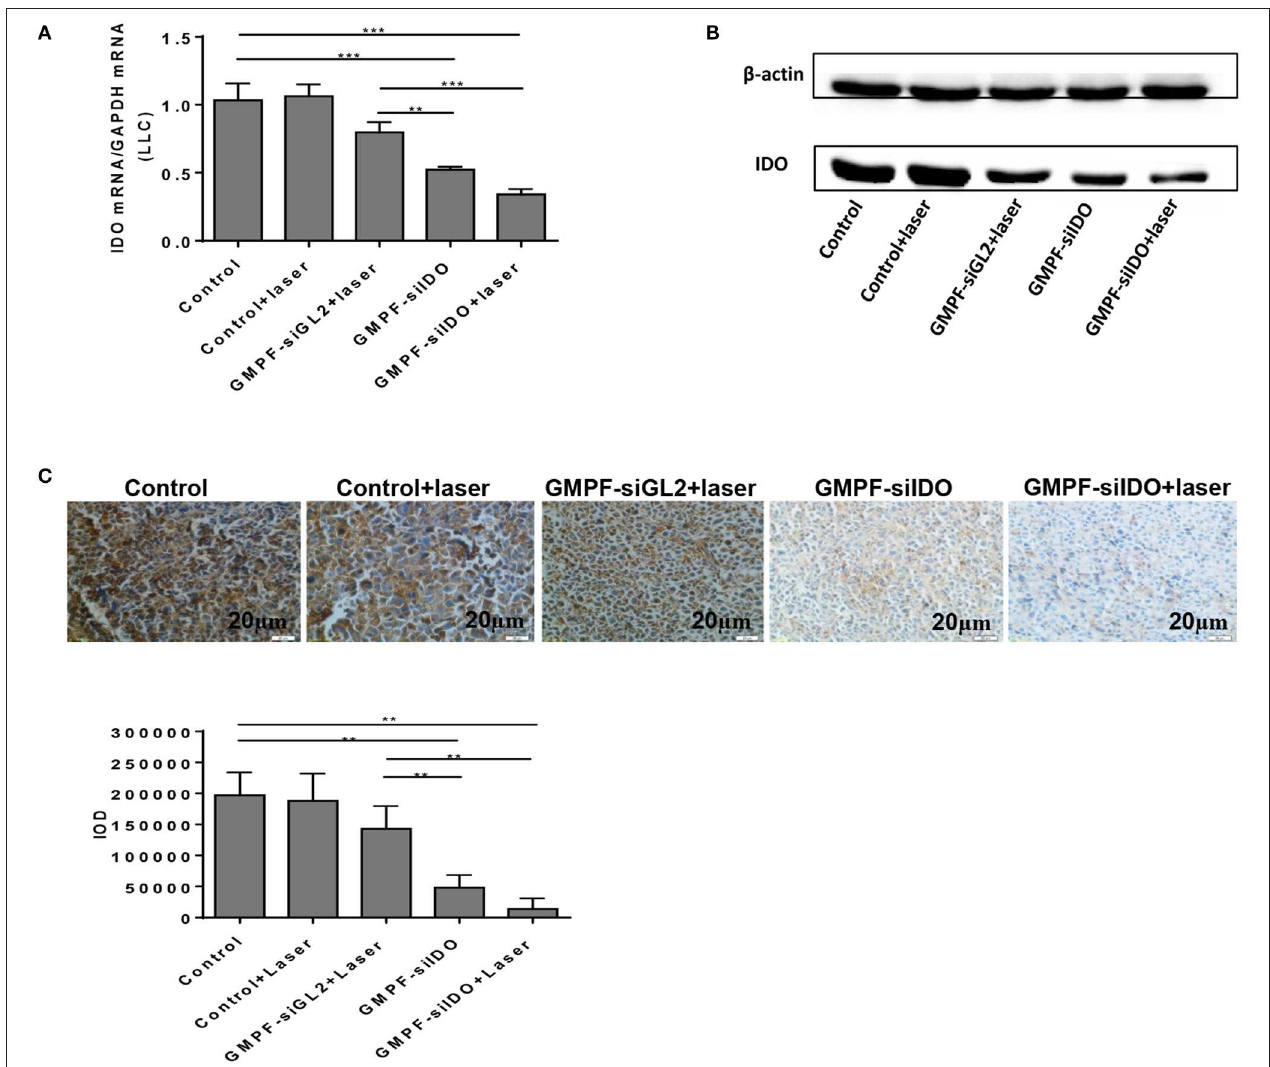
FIGURE 5 | Tumor-targeted gene silencing of IDO using GMPF-siIDO in vivo . Tumor-targeted gene silencing. Lung cancer-bearing mice were treated with PBS (control), GMPF-siGL2, or GMPF-siIDO, with or without laser irradiation. At the endpoint of the experiment, the mice were sacrificed, and tumor tissues were collected. The IDO expression was detected by RT-qPCR (A) , western blot (B) , and immunohistochemistry assays (C) . Error bars represent the standard deviation of three experiments. Error bars represent the standard deviation of three experiments (** P < 0.01; *** P <